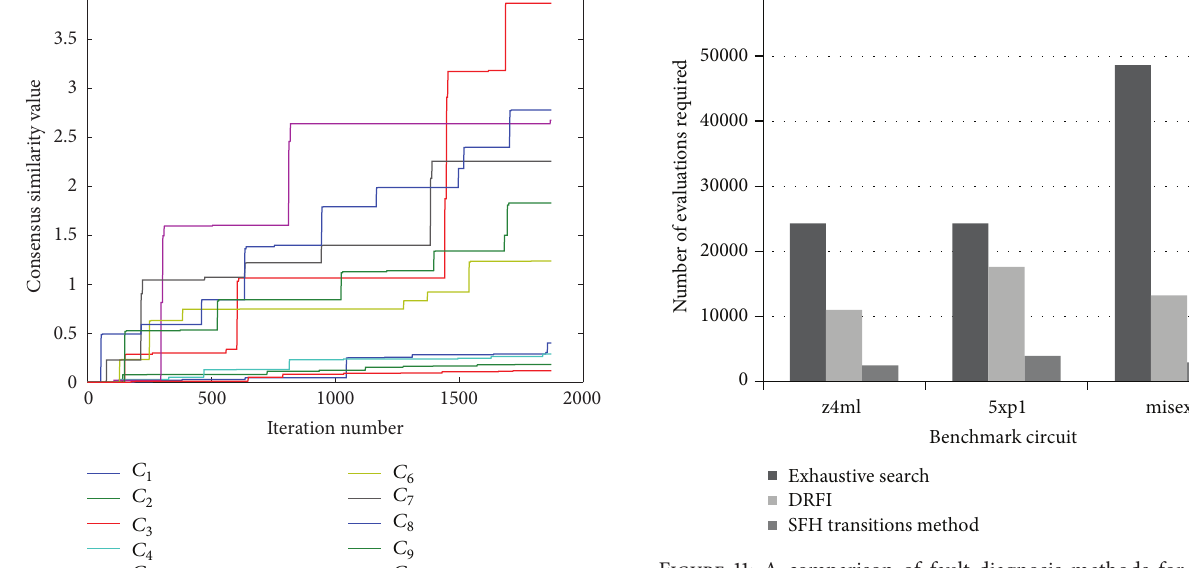
Figure 11: A comparison of fault-diagnosis methods for various MCNC